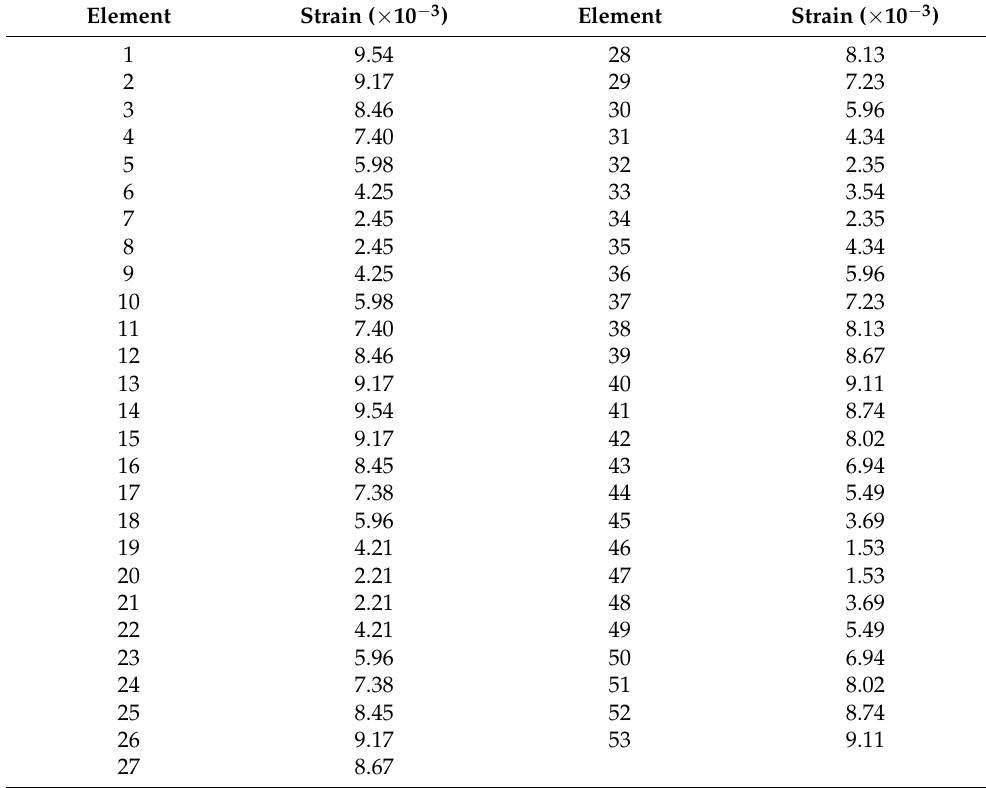
Table 2. The calculated strain value of each element.